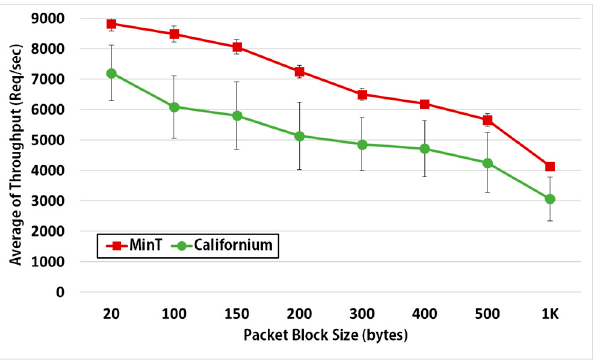
Figure 17. Average throughput for various packet block sizes in MinT and Californium (SE).